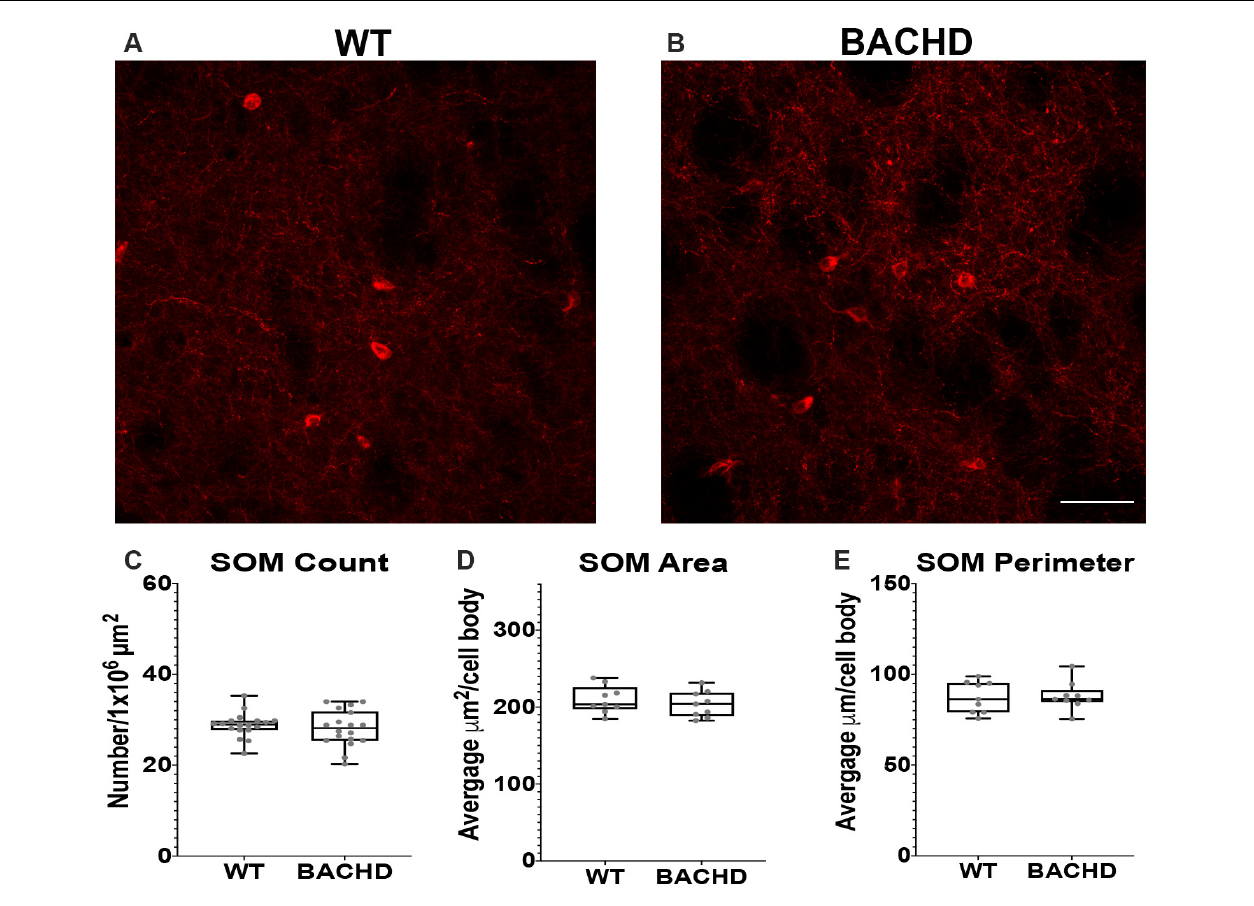
FIGURE 3 | Somatostatin interneurons are not altered in BACHD mice. Indirect immunofluorescence using an antibody to somatostatin in the striatum of 12–14 mos old WT (A) and BACHD (B) mice. SOM+ neuron number ( C ; p = 0.4957), area ( D ; p = 0.5457), and perimeter ( E ; p = 0.9314) are shown. The Mann–Whitney test was used for the analyses. n = 3 WT and n = 3 BACHD. Scale bar is 50 µ